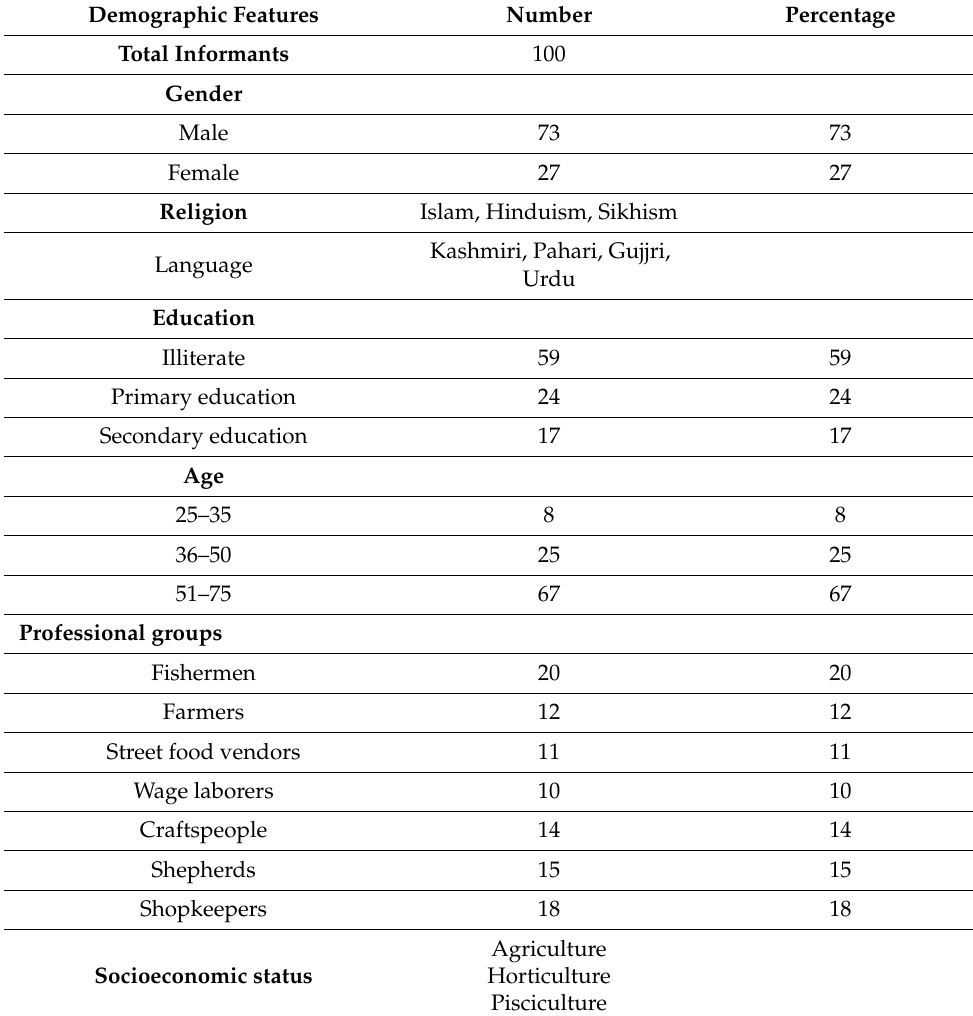
Table 1. Demographic information of informants from the Vale of Kashmir,